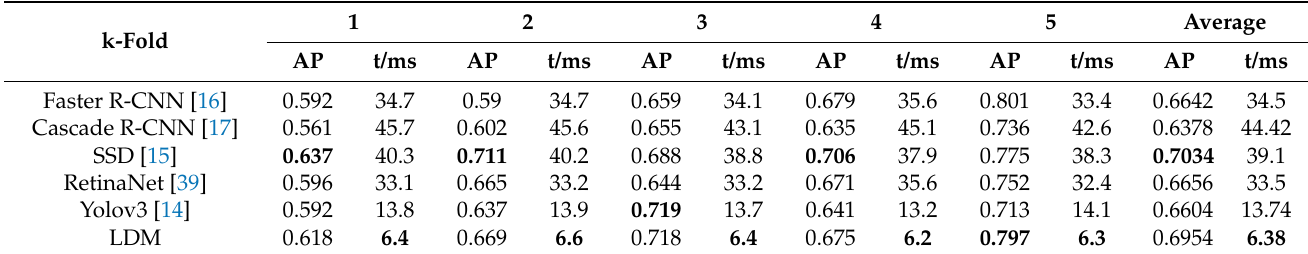
Table 1. K-fold experiments on SAR-ADD.